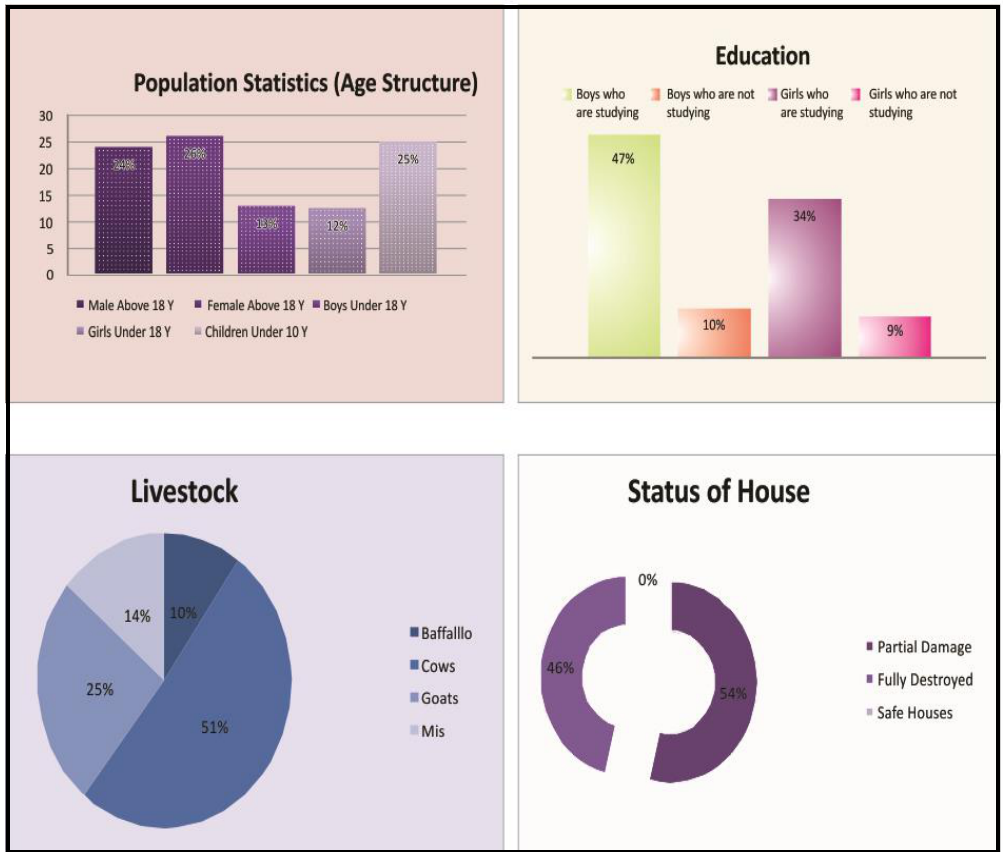
Figure 3. Physical and Social Profile of UC Agra village